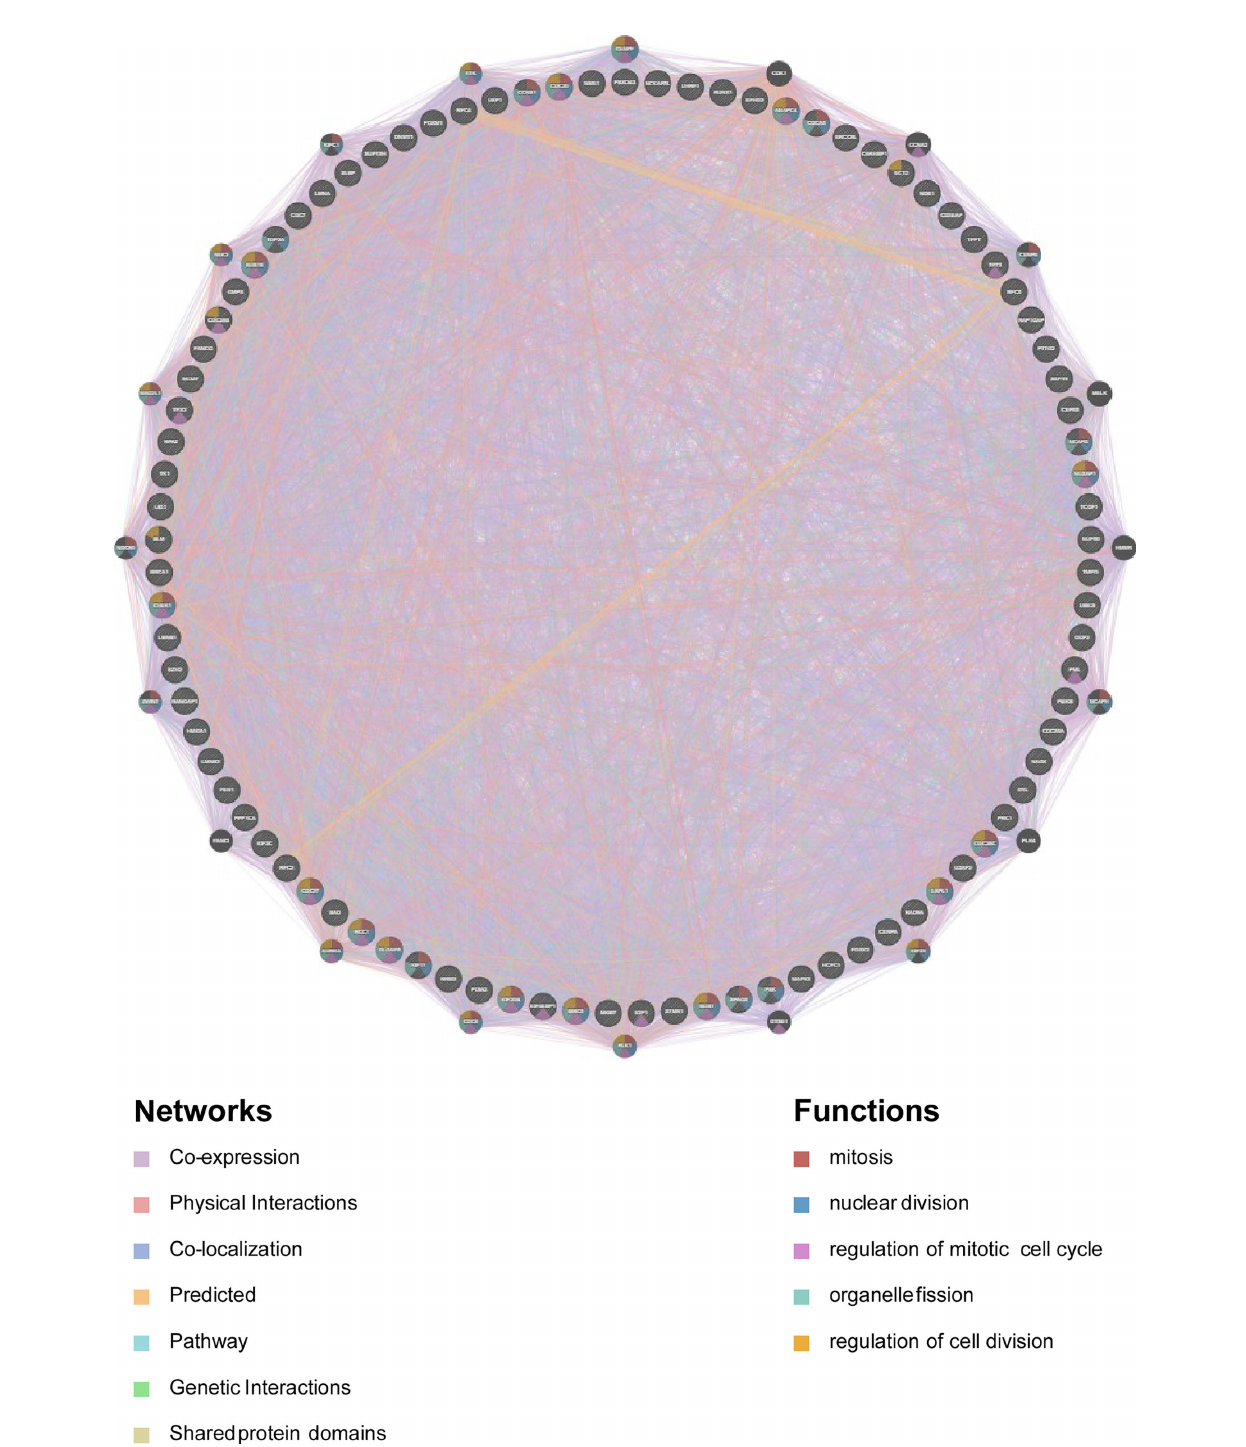
FIGURE 6 | Protein – protein interaction network of CDK kinase-target networks (GeneMANIA). Protein – protein interaction (PPI) network and functional analysis indicating the gene sets enriched in the target network of ATR kinases. Different colors of the network edges indicate the bioinformatics methods applied: co- expression, website prediction, pathway, physical interactions, and co-localization. The different colors of the network nodes indicate the biological functions of the enriched gene sets.